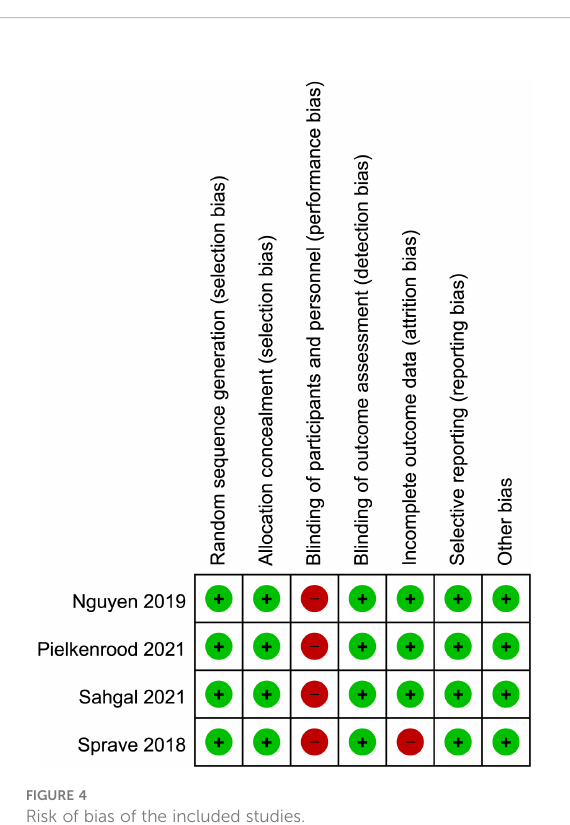
FIGURE 4 Risk of bias of the included